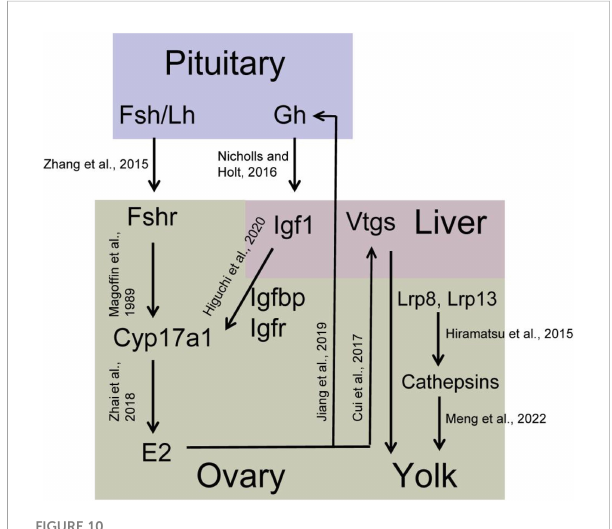
FIGURE 10 Predicted schematic overview of the yolk synthesis regulatory network in S. argus.